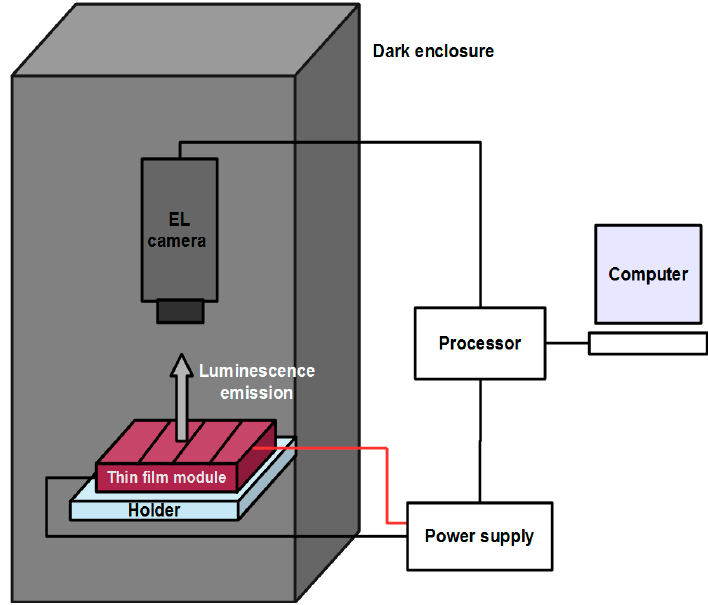
Figure 3. Schematic of EL imaging measurement system.